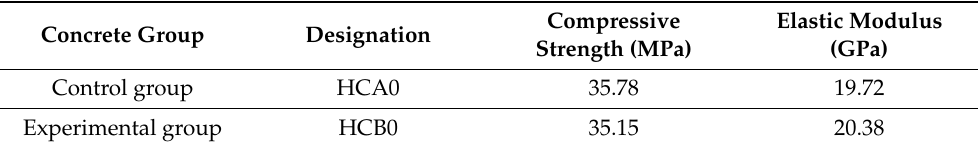
Table 11. Test results of compressive strength and elastic modulus of the concrete after exposure to high temperature.